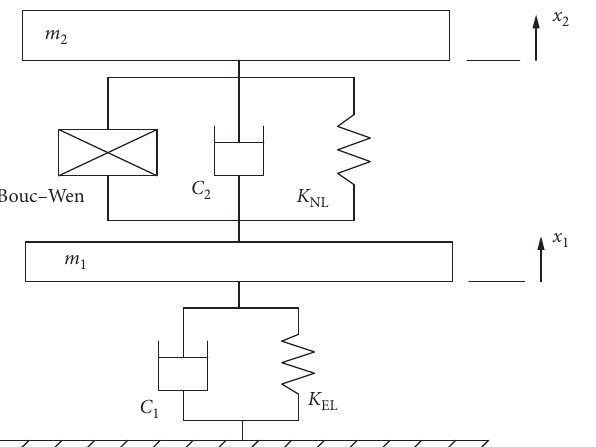
Figure 2: The SDoF primary system coupling with HNES (the HNES